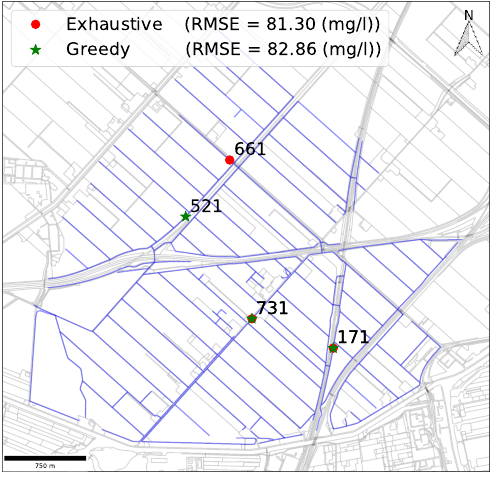
Figure 12. Comparison of optimization results using an exhaustive search and greedy